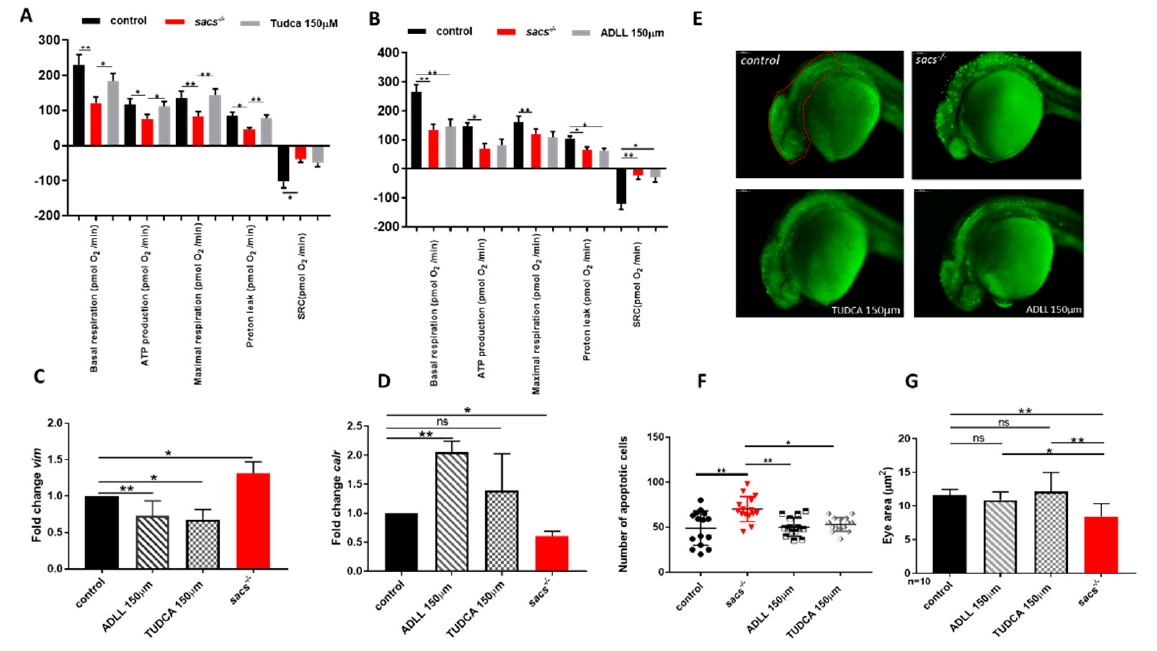
Figure 5. ADLL and TUDCA restore gene expression profile and prevent apoptosis in sacs − / − larvae. ( A , B ) Mitochondrial respiratory analysis after drug treatments. For each experiment, we compared treated sacs − / − larvae ( n = 18) and untreated sacs − / − larvae ( n = 18) and control ( n = 18) at 120 hpf. * p ≤ 0.05, ** p ≤ 0.01, calculated by the non-parametric Kruskal-Wallis test. ( C , D ) qRT-PCR analysis on sacs − / − larvae after drug treatments. Three independent RNA samples from each group (controls, untreated sacs − / − and treated sacs − / − ) were evaluated. * p ≤ 0.05, ** p ≤ 0.01, calculated by Dunnett’s multiple comparisons test. Abbreviation: ns, not significant ( E ) Detection of dying cells by acridine orange staining of 24 hpf sacs − / − embryos after drug treatments. The total number of embryos used per group tested (controls, untreated sacs − / − and treated sacs − / − ) was 15. ( F ) Apoptotic cells were counted in the area defined by the red circle. Quantitative analysis of apoptotic cells. * p ≤ 0.05; ** p ≤ 0.01, calculated by the non-parametric Kruskal-Wallis test. The values are expressed as mean ± standard deviation. ( G ) Evaluation of the eye area of sacs − / − after drug treatments (controls, untreated sacs − / − and treated sacs − / − ). * p ≤ 0.05, ** p ≤ 0.01, calculated by the non-parametric Kruskal-Wallis test. The values are expressed as mean ± standard deviation. Abbreviations: n , total number of evaluated embryos; error bars indicate standard errors of the means; ns, not significant.